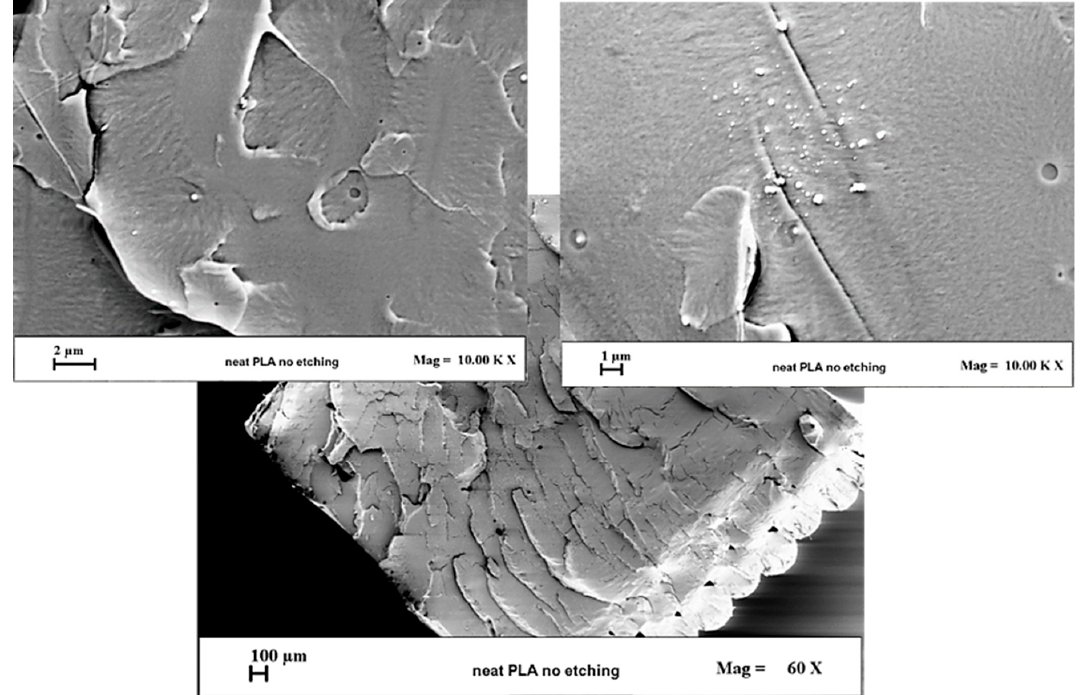
Figure 5. SEM images of pure poly(lactic) acid (PLA) surfaces obtained by cold nitrogen breakage.